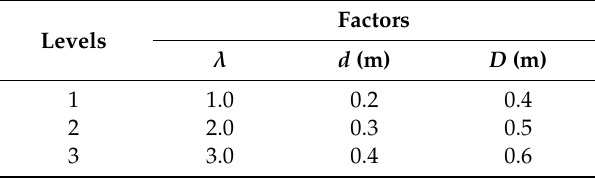
Figure 10. Dimensional sketch of cone-cylinder foundation. Table 4. Levels of three dimension factors.